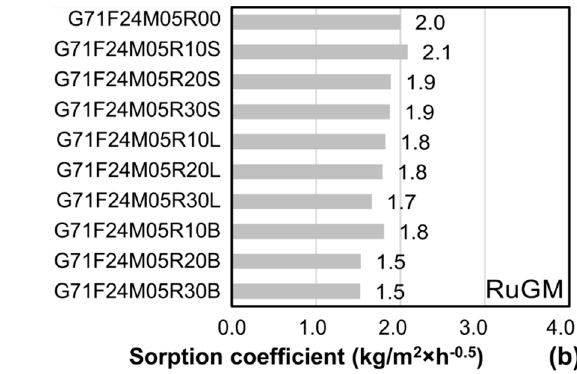
Figure 6. Sorption coefficient for: ( a ) CGM, ( b ) RuGM.